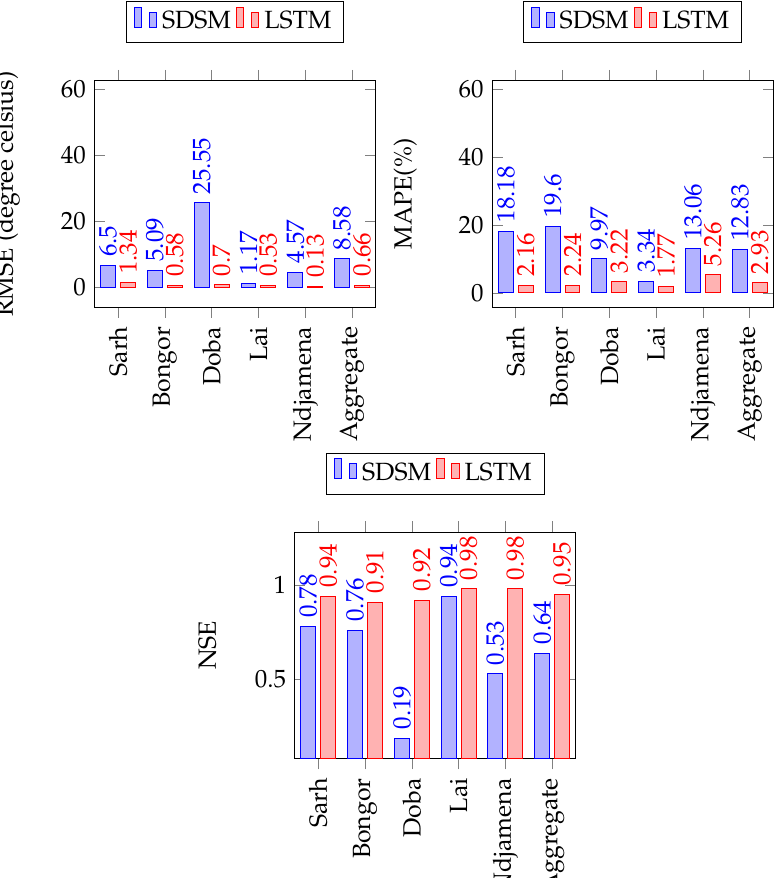
Figure 16. SDSM and LSTM forecasting performance comparison for monthly minimum temperature